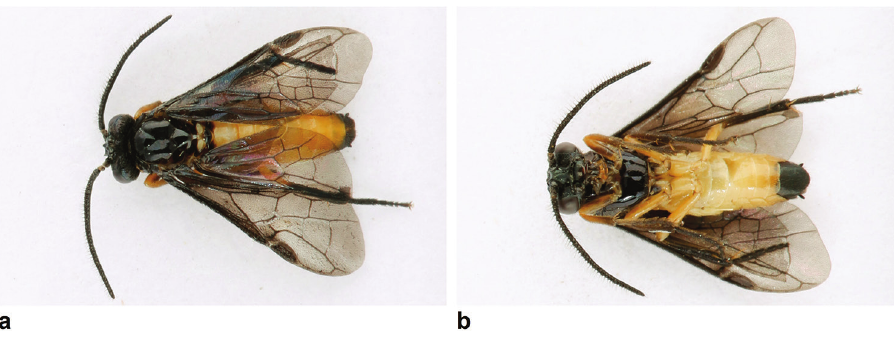
Figure 9. Scobina sp., male (P4232.C), body length 6.0 mm. a Dorsal view b ventral view. Family Pergidae Acordulecera spp. Fig. 10 Material. Estación científica Yasuní, 00°33'S, 076°31'W, 260m, 15.11.2016, on leaf of Heliconia sp., P4219.A (1 ♀ ), leg. J.-L. Boevé; Nanegal, Reserva Biológica Maqui- pucana, 00°07'N, 078°38'W, 1380m, 25.11.2016, on leaf of Melastomataceae, P4236 (1 ♀ ), leg. J.-L.